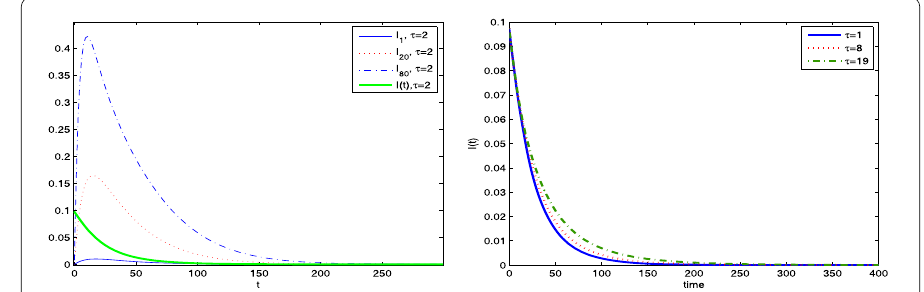
Figure 1 Dynamical behaviors of system (4) with R 0 =